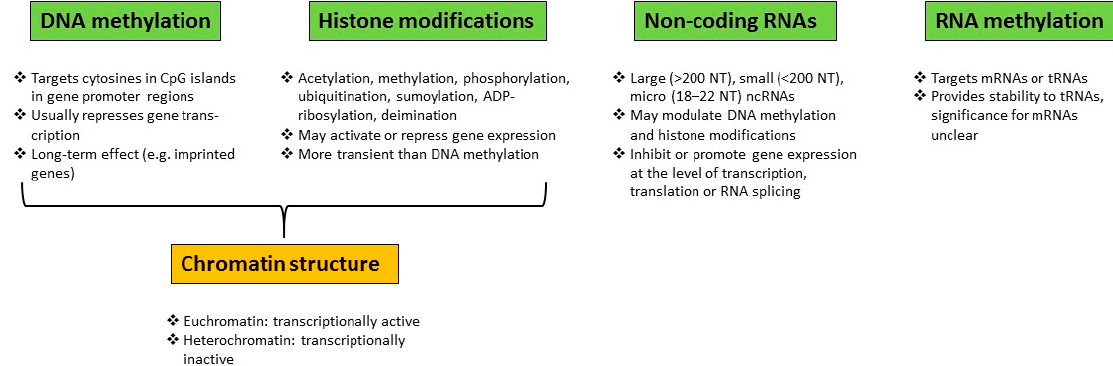
Figure 1. Epigenetic mechanisms affecting gene expression and their key features. 72